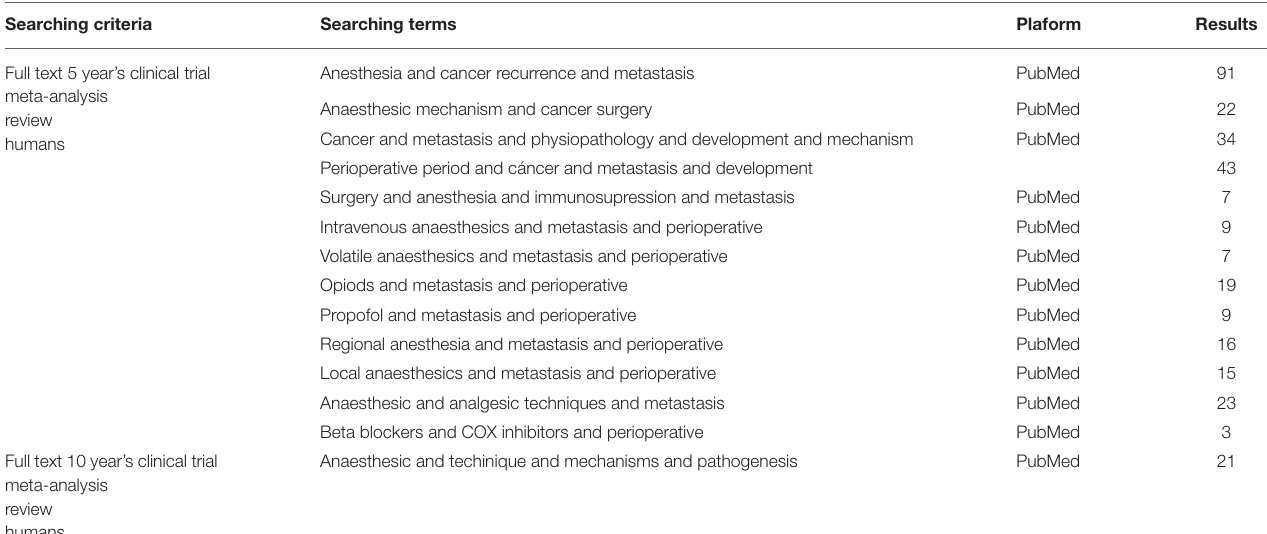
TABLE 1 | Results obtained for each search term and criteria. Searching criteria Searching